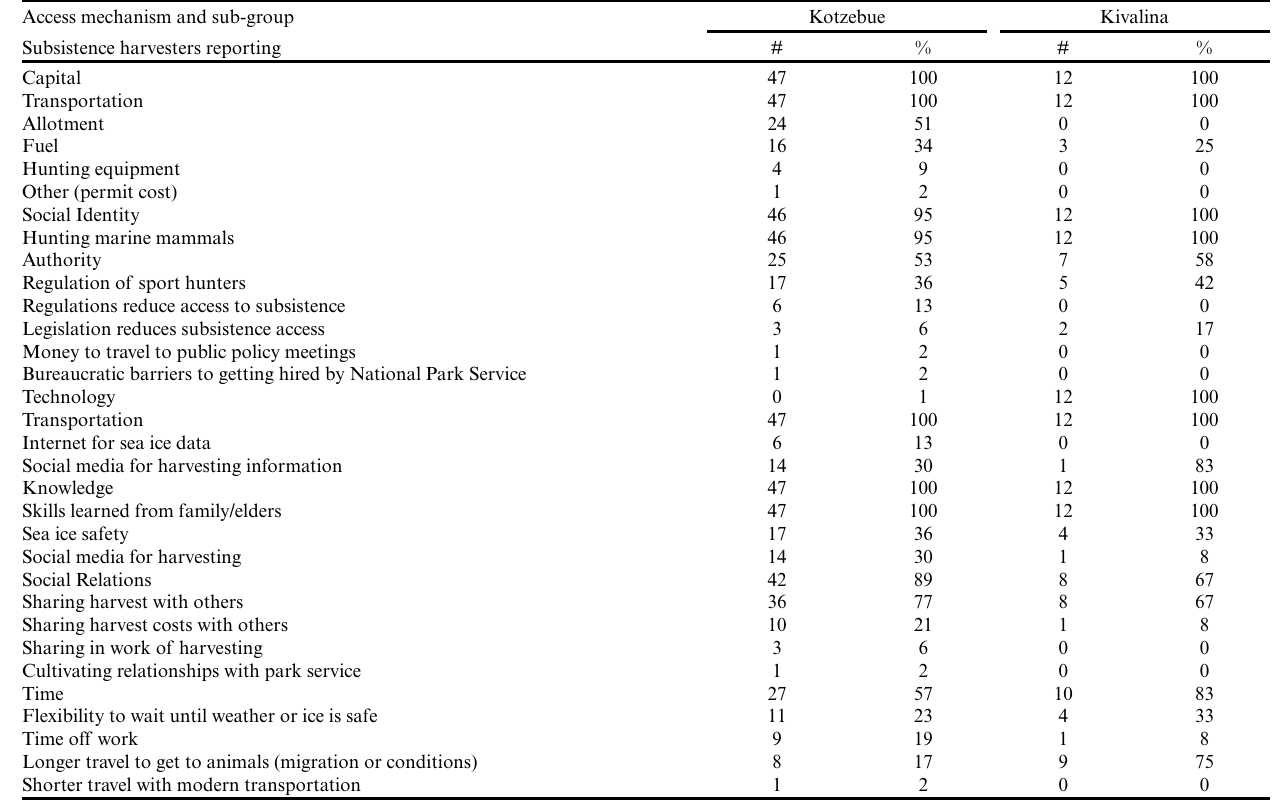
Table 3 . Access mechanisms and sub-mechanisms reported to influence access to harvest by number and percentage of subsistence harvesters in Kotzebue and Kivalina. Major access mechanism categories were reported present if any of the sub-mechanisms were reported. Individual responses were tallied from group and couple